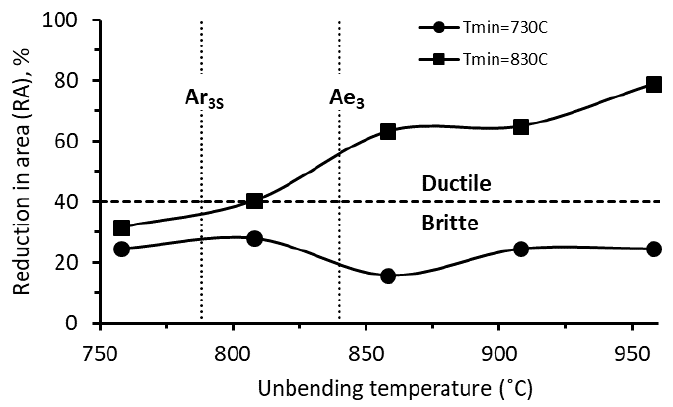
Figure 3. Influence of T min on hot ductility for T max = 1030 °C. Poor ductility resulted at all unbending temperatures after a T min of 730 °C [7]. Ae 3 = 840 °C and Ar 3P = 660 °C.